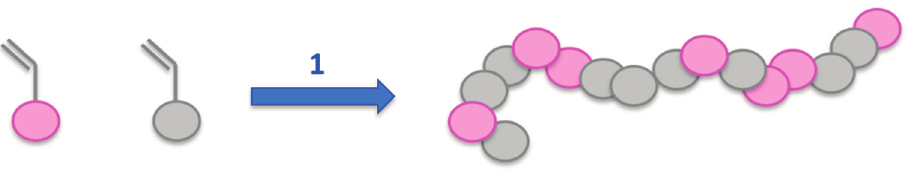
Figure 3. Schematic illustration of the preparation of polymeric dyes via copolymerization of colored